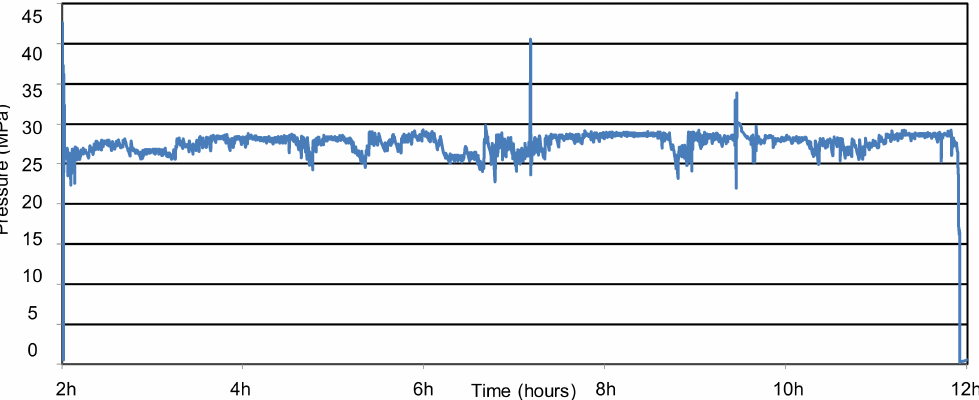
Figure 6. Measuring the pressure in the cylinder of the canopy supports during the sudden clamping of the excavation.